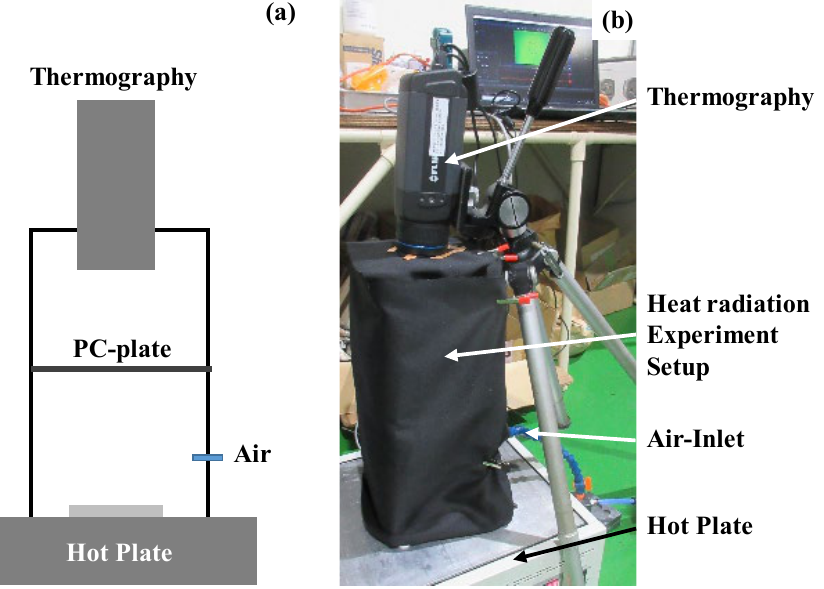
Figure 4. Heat radiation experimental setup. ( a ) Schematic view on the heat radiation from the specimen to the sample plate, in situ measured by the thermography and ( b ) overview on the experimental setup.